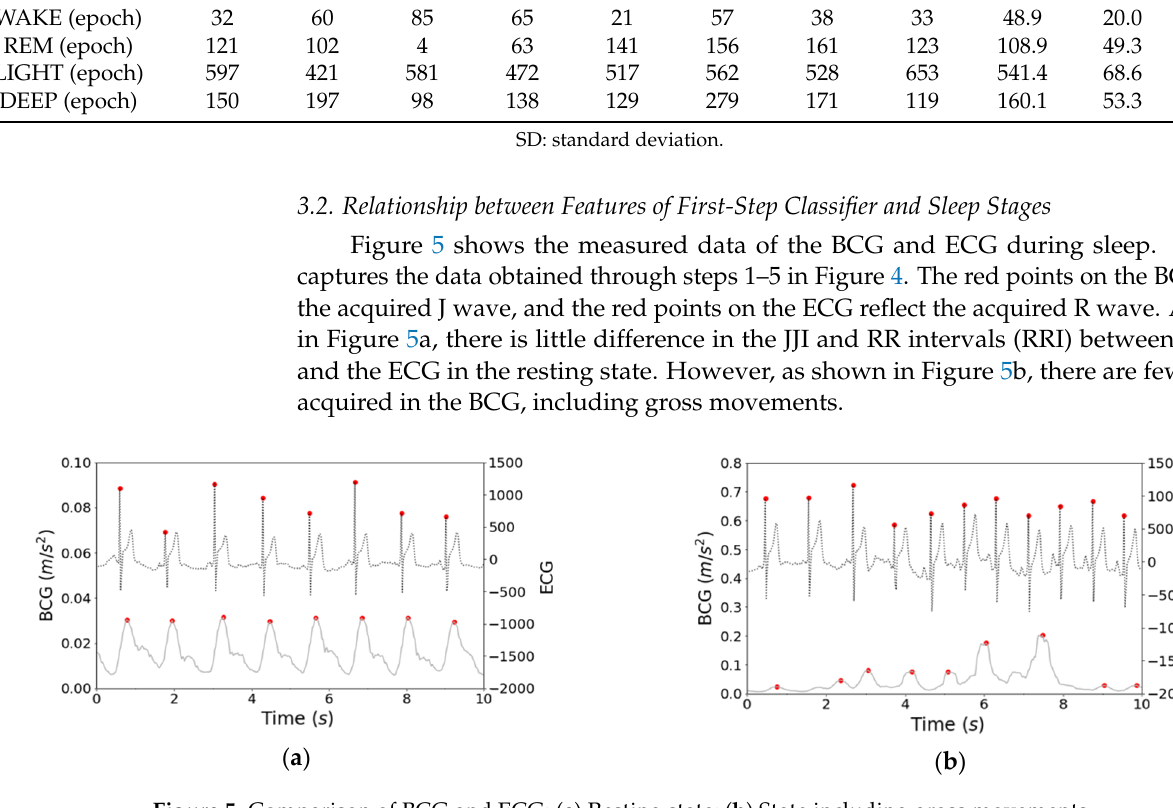
Figure 5. Comparison of BCG and ECG: ( a ) Resting state; ( b ) State including gross movements.